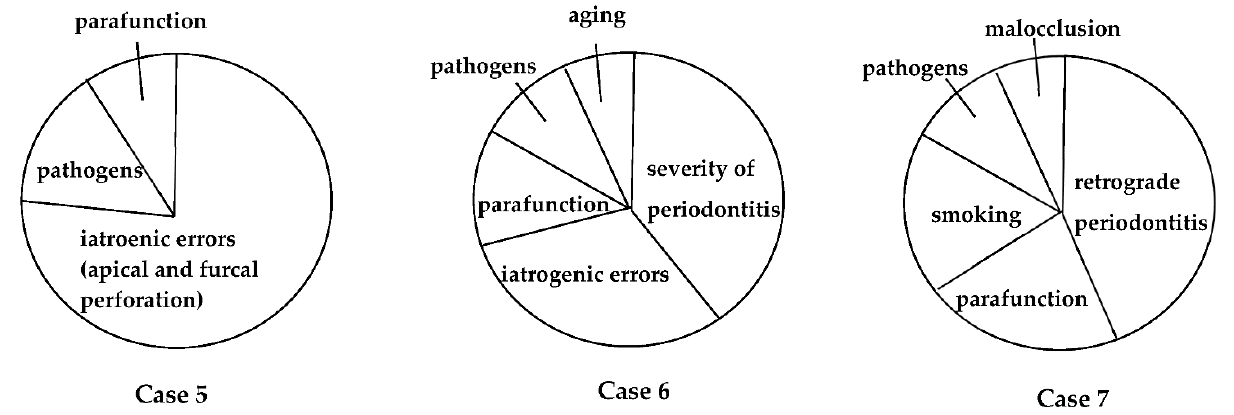
Figure 9. Causal/risk factors associated with EPLs in the patients described in Figures 6–8. These factors may influence the progression and pathogenesis of each